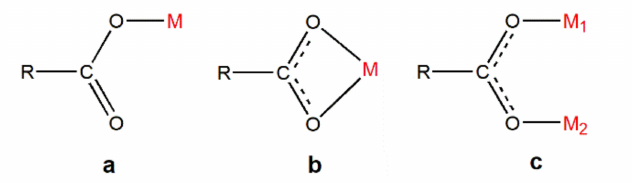
Figure 9. The coordination pattern of carboxyl group: ( a ) Monodentate coordination; ( b ) chelation coordination; ( c ) bridge